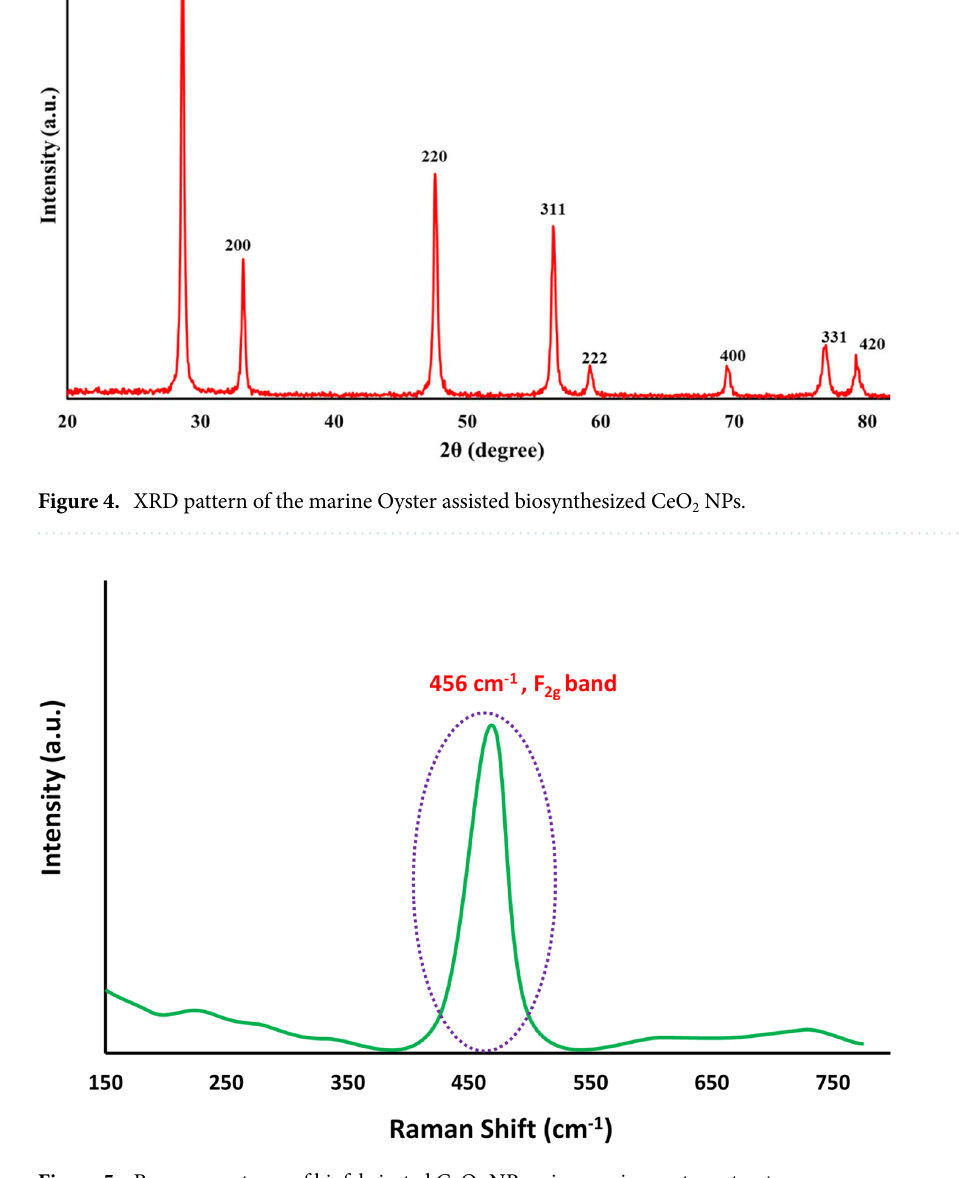
Figure 5. Raman spectrum of biofabricated CeO 2 NPs using marine oyster